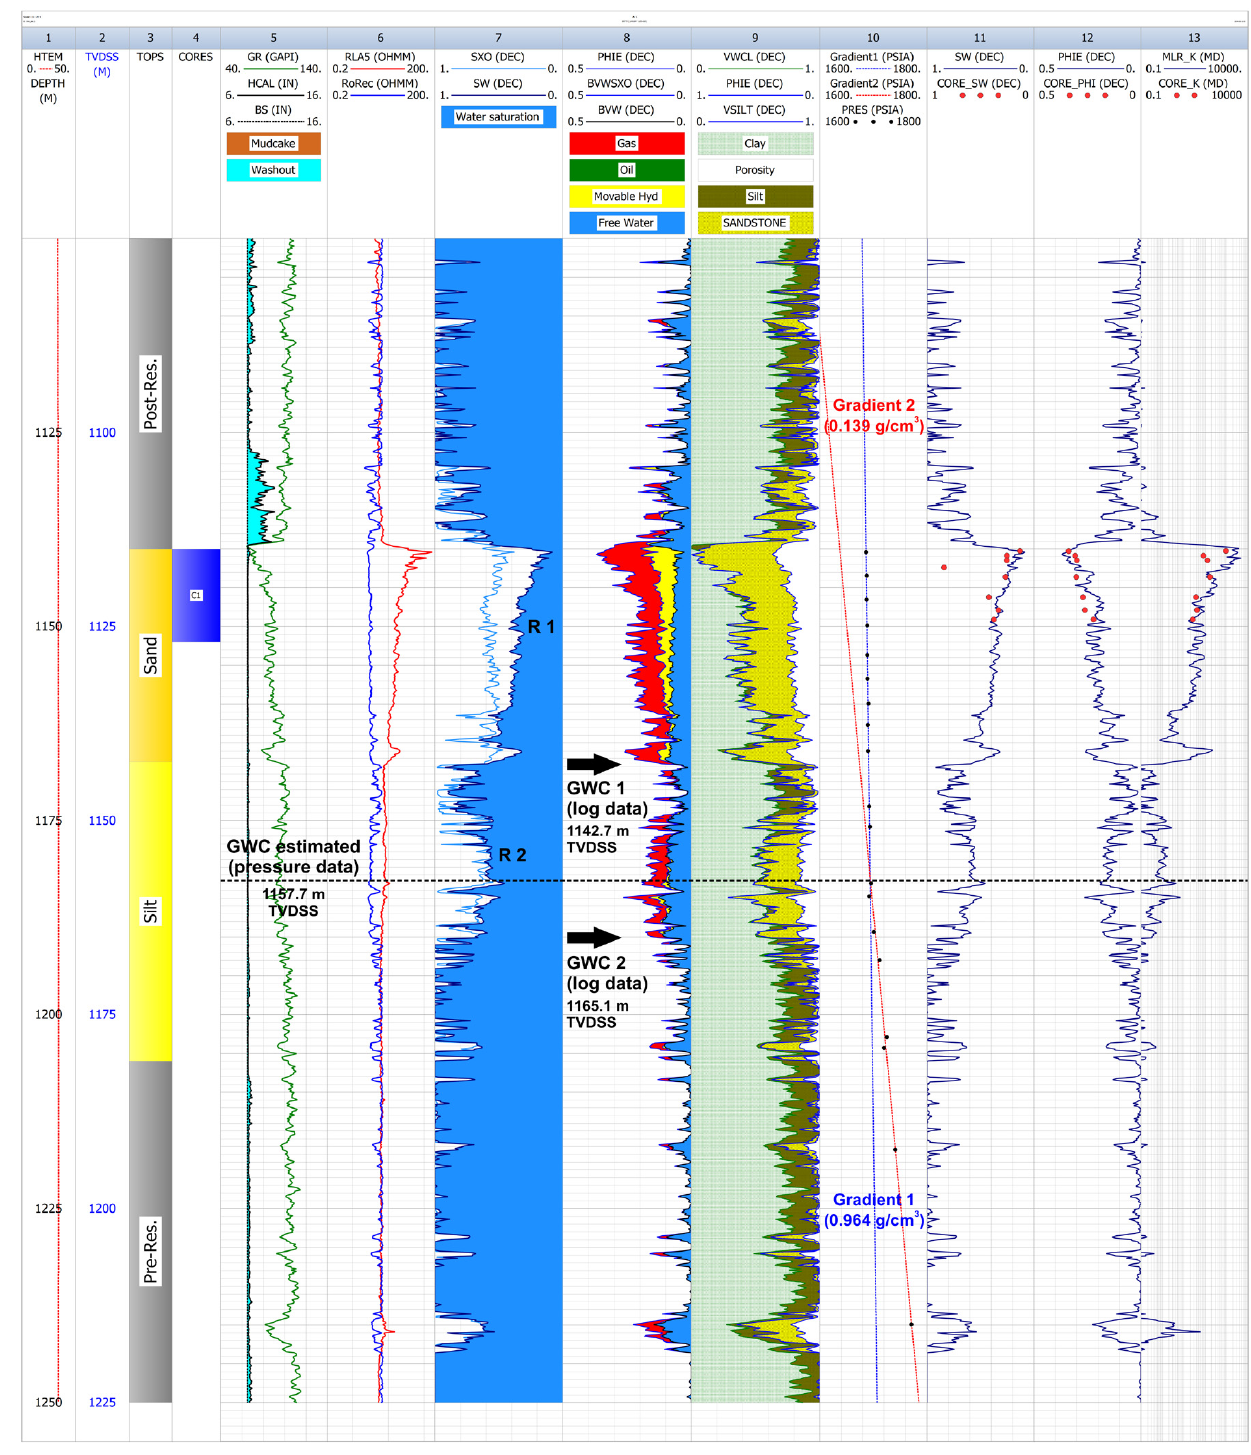
13 Figure 13. Example of deterministic log interpretation results for well A-1. HTEM —borehole temperature, GR —gamma-ray intensity, HCAL —caliper, BS —bit size, RLA5 —deep Laterolog apparent resistivity, RoRec —reconstructed R 0 resistivity, SW —uninvaded zone water saturation, SXO —flushed zone water saturation, PHIE —effective porosity, BVW —uninvaded zone bulk volume of water, BVWSXO — flushed zone bulk volume of water, VWCL —wet clay volume, VSILT —silt